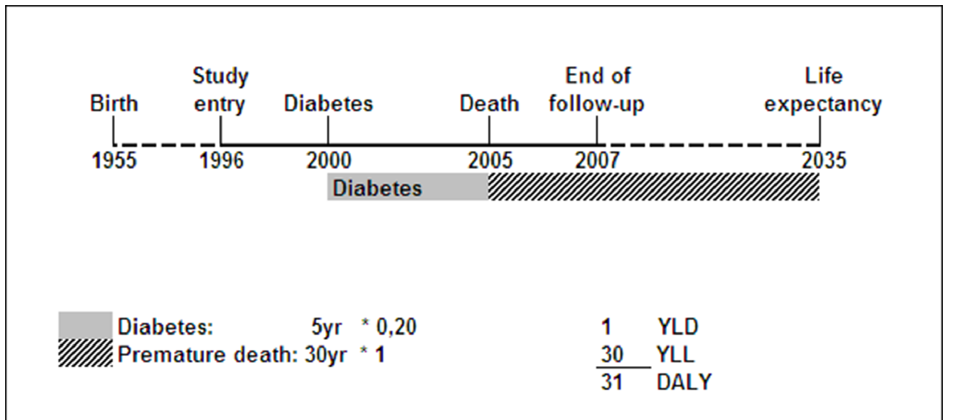
Figure 1. Example of DALY calculation for a deceased participant. Abbreviations: YLD, Years Lost due to Disability; YLL, Years of Life Lost; DALY, Disability-Adjusted Life Year. The disability weights are 0.20 for Diabetes and 1 for death.